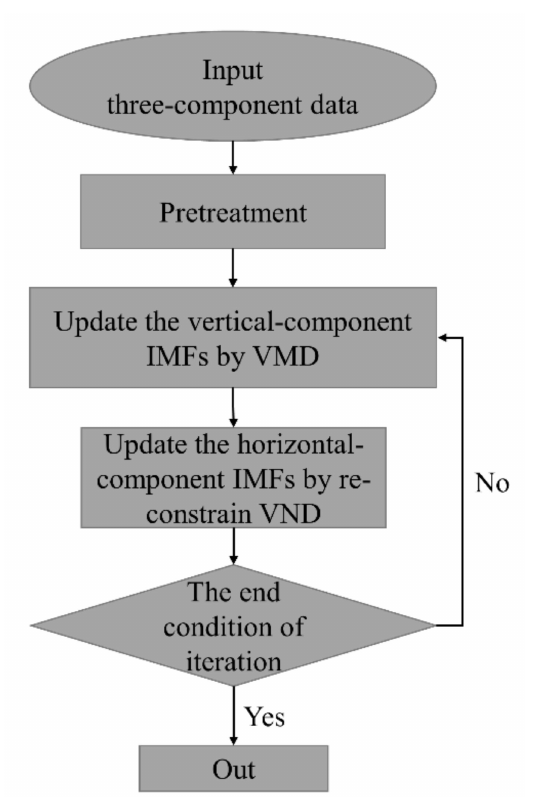
Figure 1. Flow chart of processing the three-component microseismic data by re-constrain